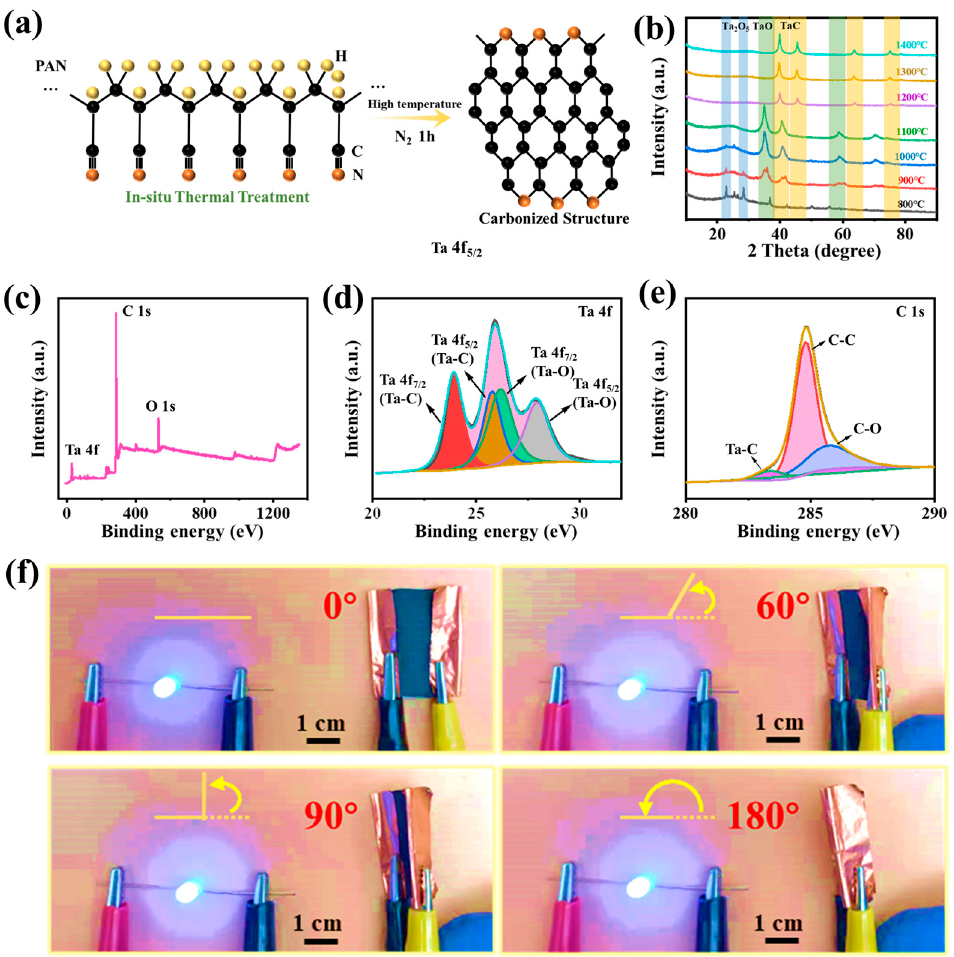
Figure 2. ( a ) The structural evolution of PAN under thermal treatment from the ladder structure to the carbonized structure. ( b ) XRD pattern of various samples at different carbonization temperatures. XPS survey scan of electrospun TaC/C fibers: ( c ) Full energy spectrum; ( d ) Ta 4f; ( e ) C 1 s. ( f ) Flexibility test of TaC/C electrospun fabrics at different bending angles.